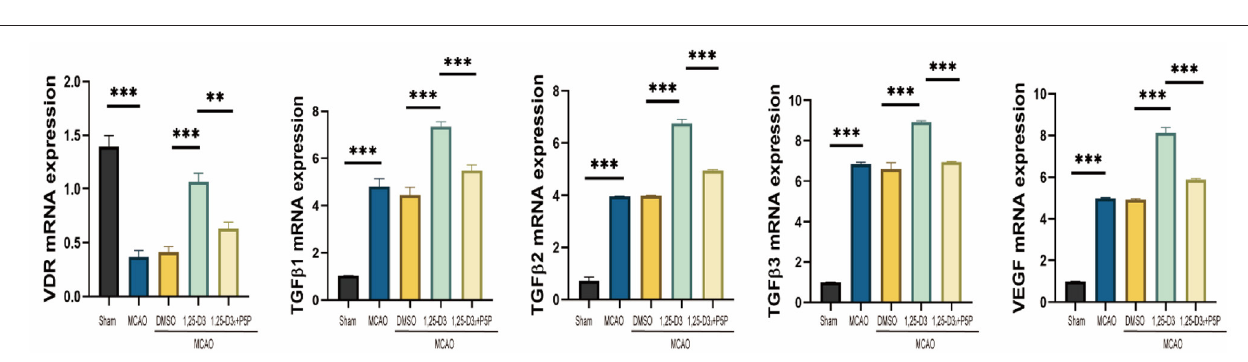
FIGURE 7 | The expression of VDR, VEGF and TGF- β 1, TGF- β 2, TGF- β 3 mRNA in MCAO rats increased after pretreatment with 1,25-D3. Data were represented as Mean ± SEM, n = 5 per group, * p < 0.05, ** p < 0.005, *** p < 0.001. MCAO, middle cerebral artery occlusion; DMSO, dimethyl sulfoxide; P5P, antagonist of VDR; 1,25-D3, 1 α ,25-dihydroxyvitamin